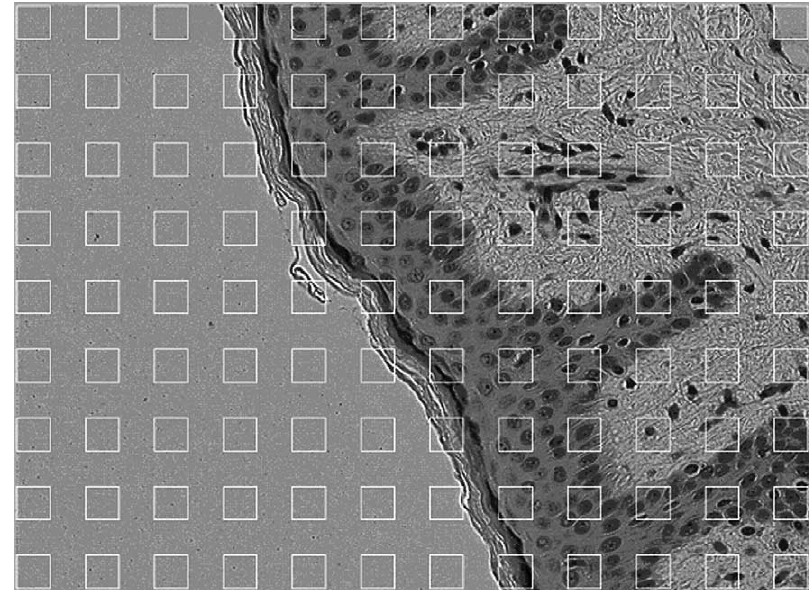
Fig. 1. A field of vision with measuring masks of equal size and shape during learning phases. Elements were interactively classified as belonging to background, tissue or